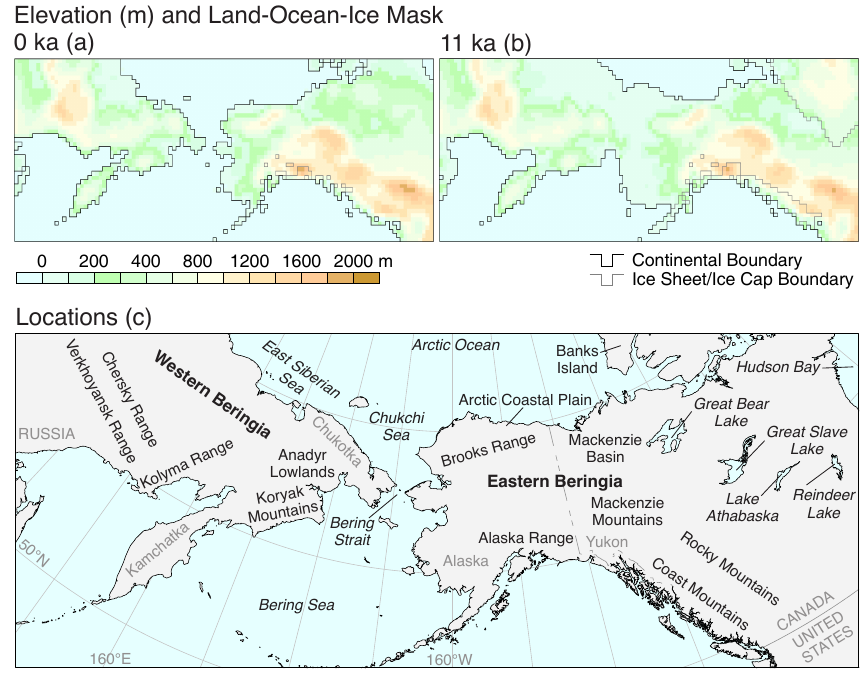
Figure 1. Spatial domain of RegCM for this study showing elevations and coastlines for 0ka (a) and 11ka (b) . The extent of the Laurentide and Cordilleran ice sheets at 11ka is indicated by fine grey lines (for ice cover see also Fig. 4). Locations and regions referred to in the text (c)